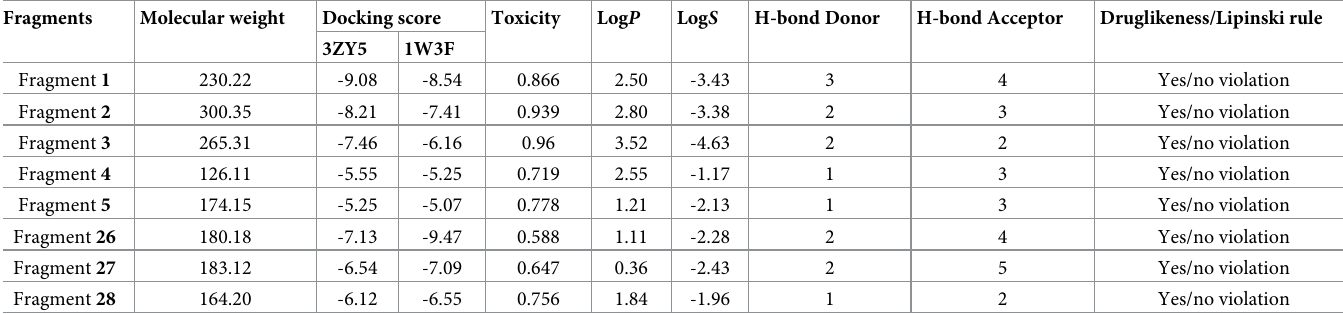
Table 1. Fragments absorption, bioavailability, and toxicity prediction, followed by Lipinski’s rule of